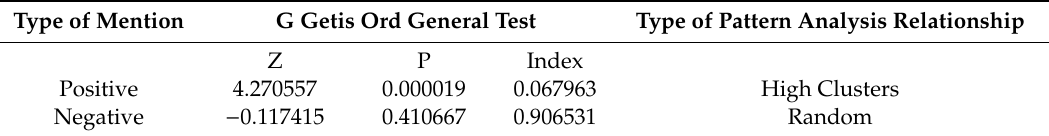
Table 6. G Getis Ord test on Customer Attention.